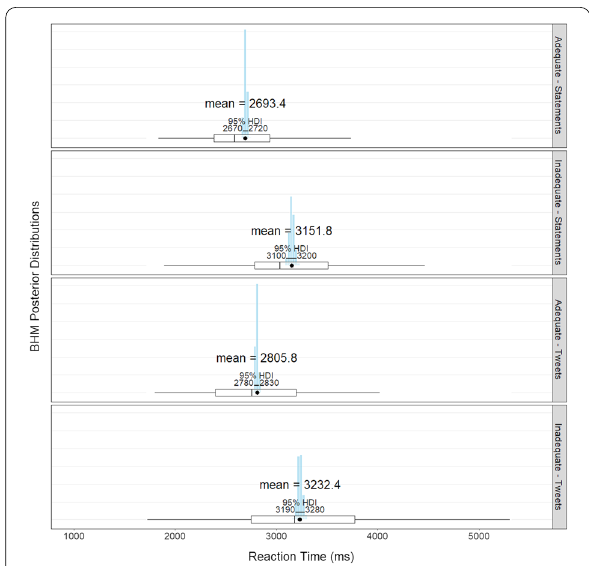
Fig. 5 Reaction time by health literacy and experiment. The blue histograms represents the mean’s posterior distribution. On top is the most likely mean value based on the BHM. In the middle is the 95% highest density interval. At the bottom is a box plot based on the raw data averaged by participant (the black dot represents the raw